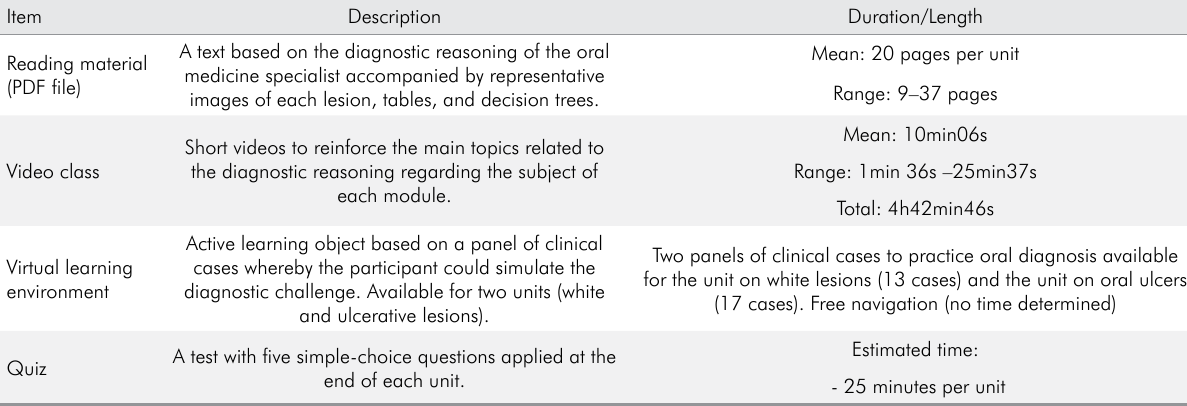
Table 1. Course´s learning